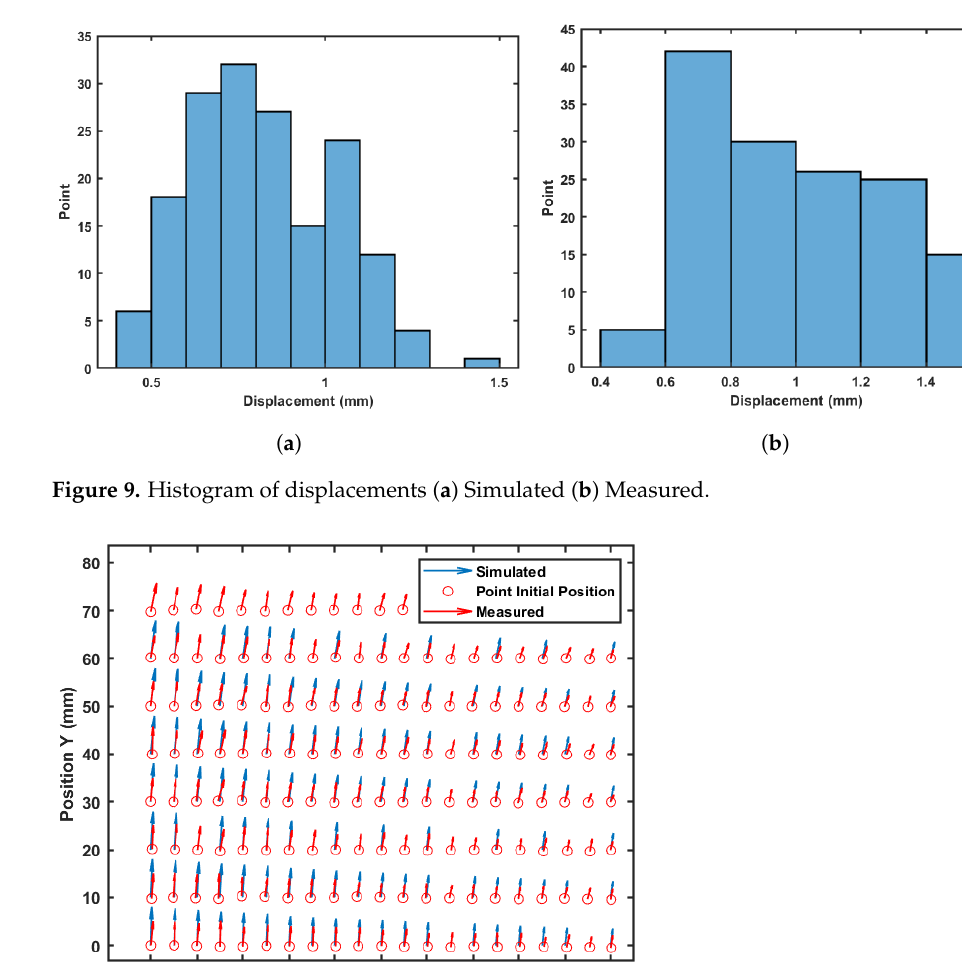
Figure 8. Overlay points positions.